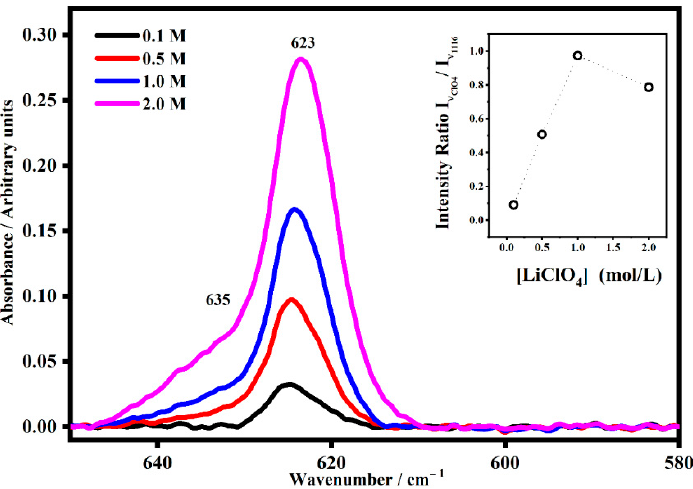
Figure 14. The IR band assigned to the ClO 4 − anion I ν ClO4 (~623 cm − 1 ) and its satellite band at I ν ClO4* (~635 cm − 1 ) in PMMA-Li-PC-EC gel polymer electrolyte at different salt concentrations: 0.1 M, 0.5 M, 1 M and 2 M. In the inset, the Intensity Trend of the band at 623 cm − 1 as a function of the salt concentrations for the PMMA-Li-PC-EC polymeric blend system. The band at 624 cm − 1 , assigned to the free anion, was normalized by the intensity band at 1116 cm − 1 , which does not depend on the lithium perchlorate concentration.